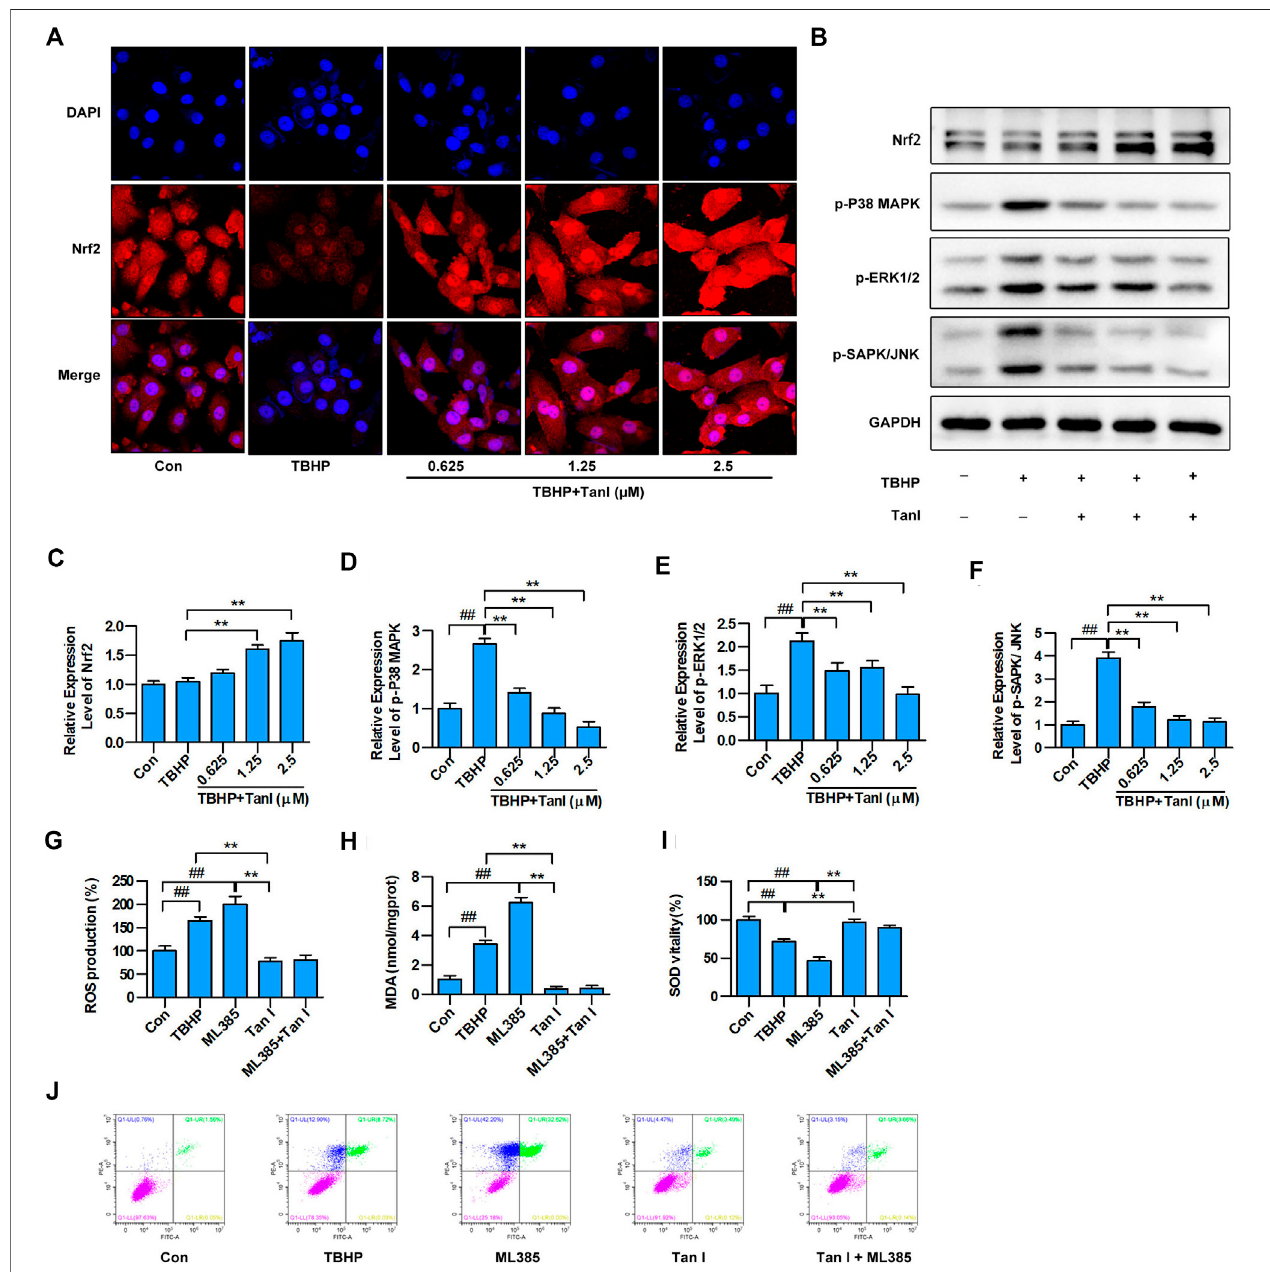
FIGURE4| TanIactivatesNrf2andinhibitsMAPKsignalinginH9C2cells. (A) H9C2cellsincubatedwithdifferentconcentrationsofTanI(0.625,1.25,and2.5 µM) and then treated with TBHP (200 µM). Detection of Nrf2 transcription into the nucleus by immuno fl uorescence ( n (cid:2) 3). (B) Expression levels of Nrf2, p-P38 MAPK, p-ERK1/2, and p-SAPK/JNK, tested using Western blotting analysis. (C) Relative expression levels of Nrf2 ( n (cid:2) 3). (D) Relative expression levels of p-P38MAPK ( n (cid:2) 3). (E) Relative expression levels of p-ERK1/2 ( n (cid:2) 3). (F) Relative expression levels of p-SAPK/JNK ( n (cid:2) 3). (G) Reactive oxygen species (ROS) levels ( n (cid:2) 3). (H) Malondialdehyde (MDA) content ( n (cid:2) 3). (I) Superoxide dismutase (SOD) activity ( n (cid:2) 3). (J) H9C2 cell apoptosis analysis( n (cid:2) 3). Data arepresentedas mean ± S.D. # p < 0.05, ## p < 0.01 , compared to the control group. *p < 0.05, **p < 0.01, compared to the TBHP or ML385 group.